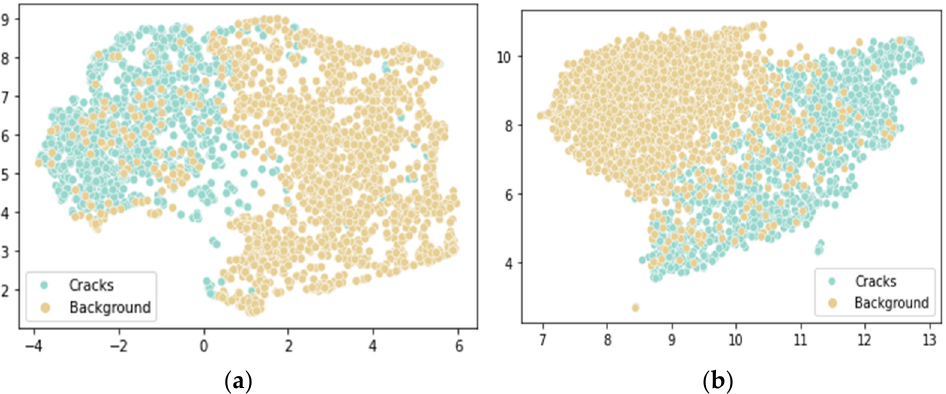
Figure 6. UMAP visualization maps of HOG and ULBP features after KPCA application: ( a ) reduced HOG features and ( b ) reduced ULBP features.